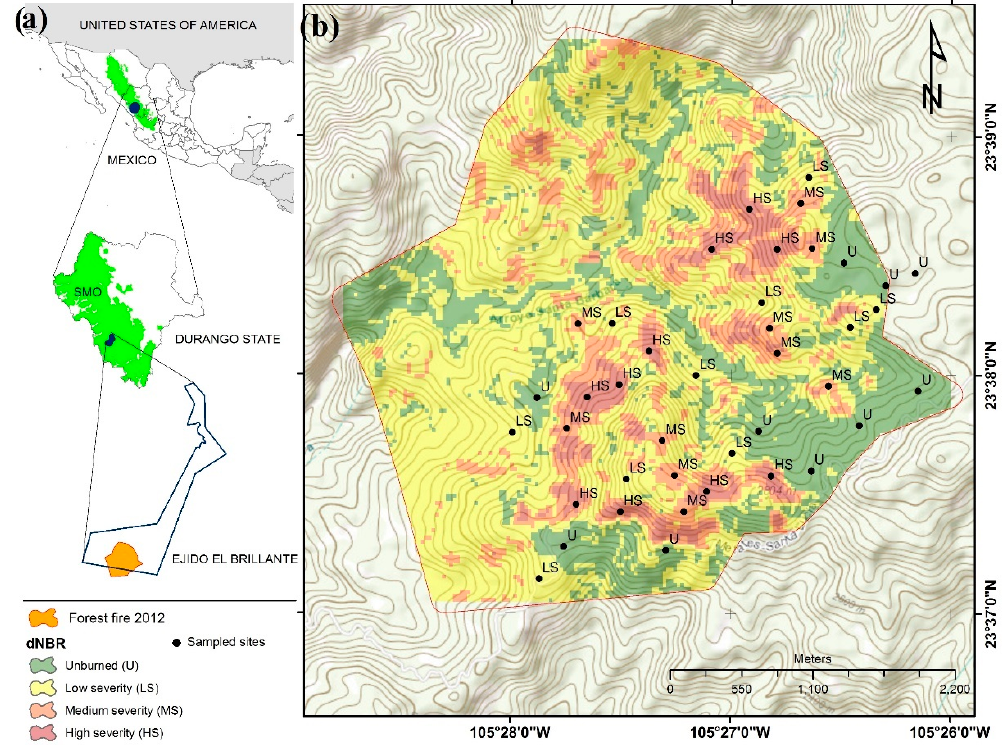
Figure 1. ( a ) Location of El Brillante ejido and the area burned in 2012 in the Sierra Madre Occidental (SMO); ( b ) fire severity levels calculated through the dNBR and distribution of sampled sites by severity level.